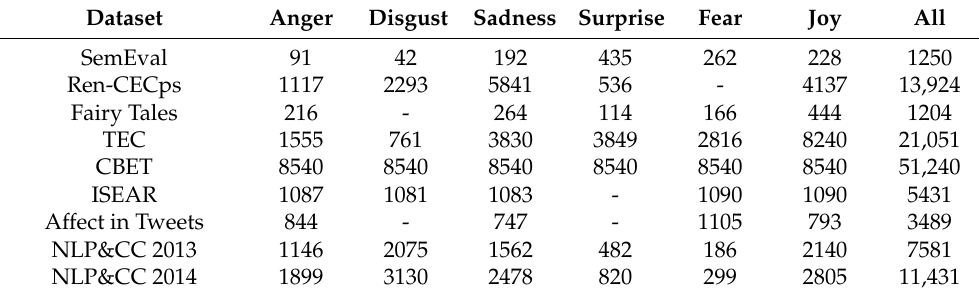
Table 1. Experimental datasets (the sentence number of each emotion in the SemEval and Ren-CECps datasets is the sentence number whose dominant emotion is the corresponding